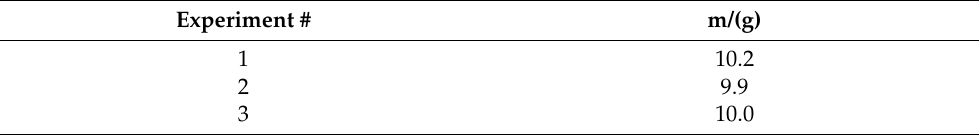
Table 4. Mass of isolated solid fraction after alkaline hydrolysis of PET foil coated with chitosan and after the addition of